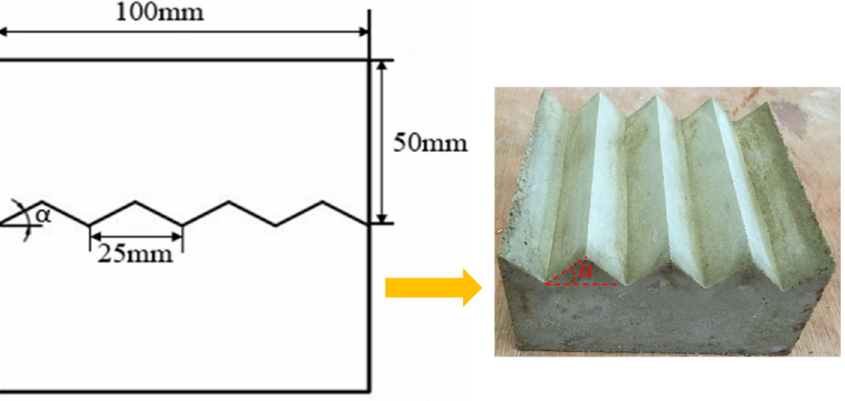
Figure 6. Schematic diagrams of saw-tooth triangular joint cement mortar specimens (Modified after Xie et al. [70]).